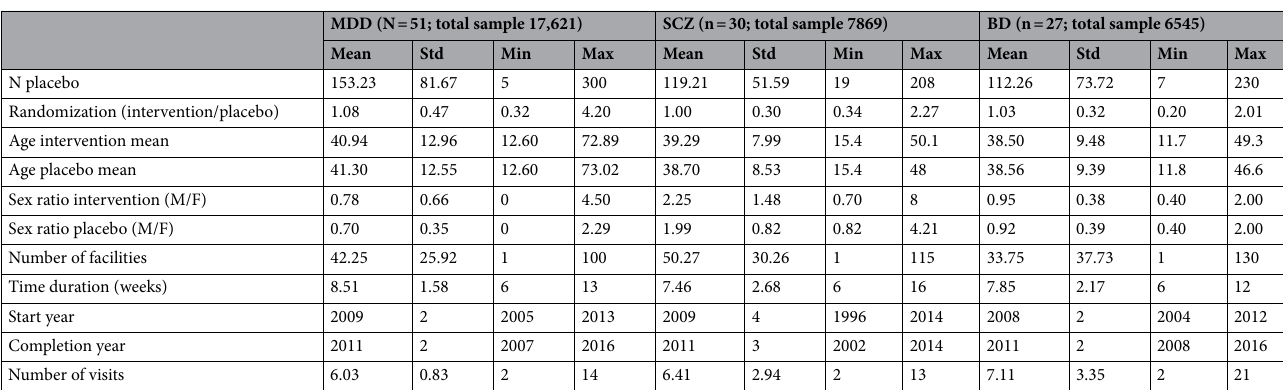
Table 1. Descriptive table of clinical trials included in the